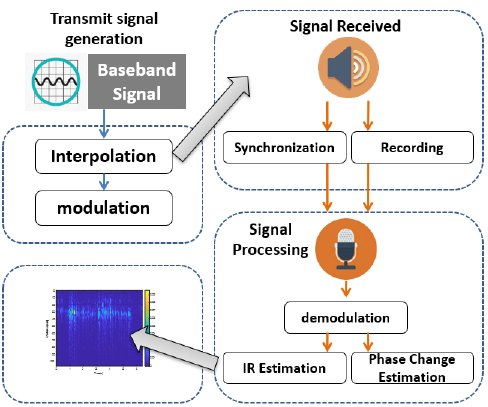
Figure 2. The overview of a sample acoustic sensing